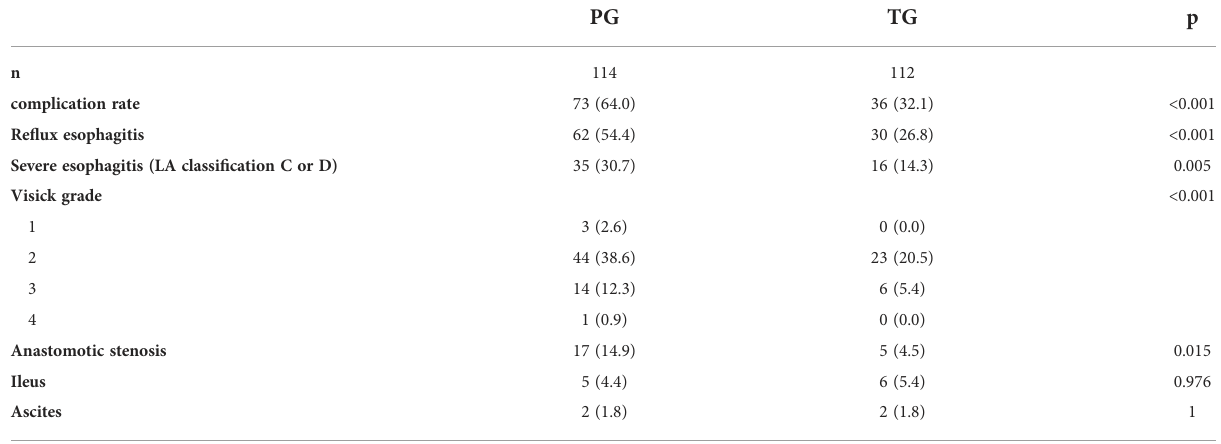
TABLE 4 Long-term outcomes.